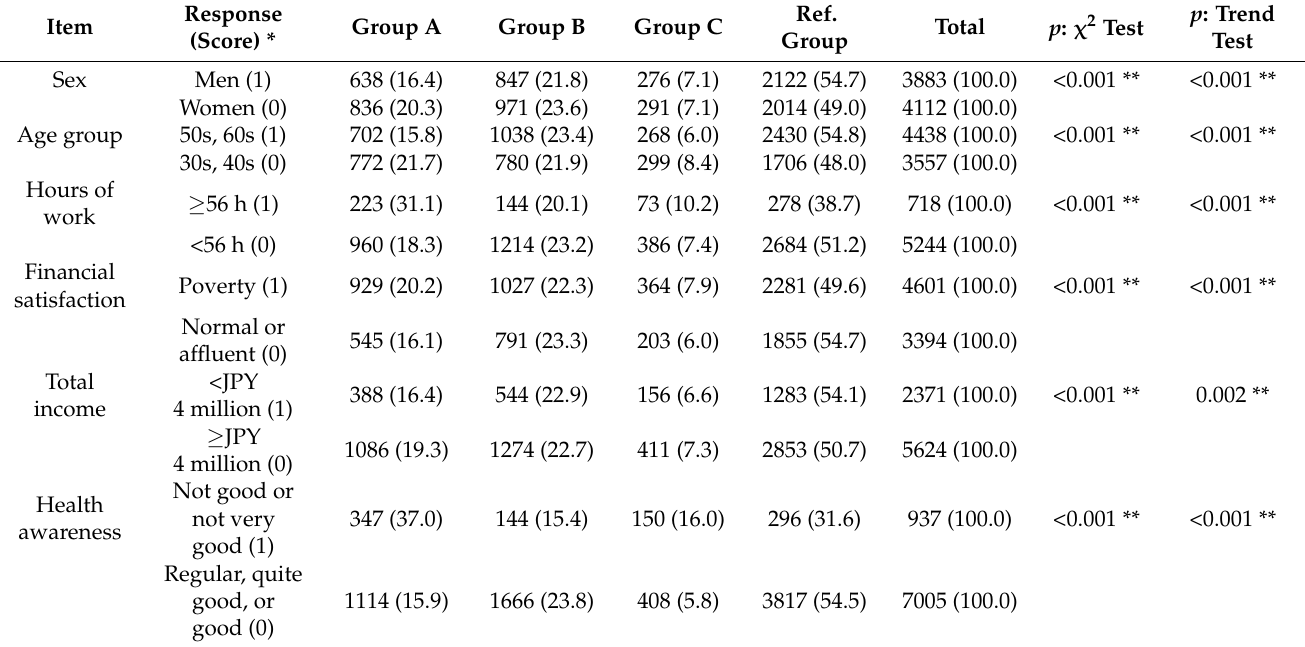
Table 2. Comparison of basic attributes, health awareness, and lifestyle habits by sleep